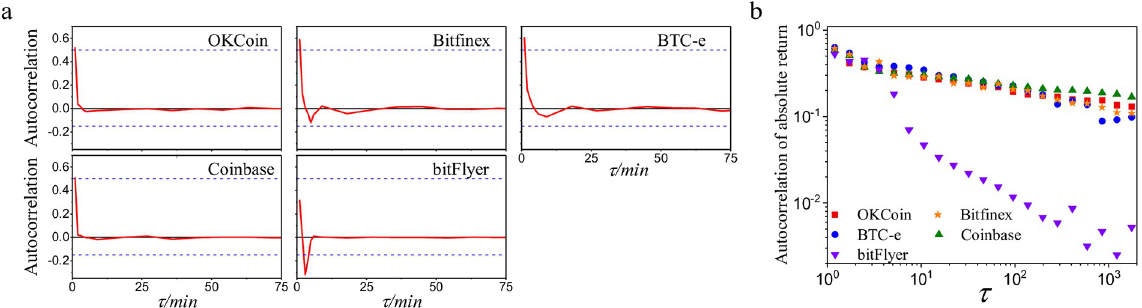
Fig 3. The dependence property of price return. a , The linear autocorrelation of normalized price return in different Bitcoin platforms when time interval Δ t = 2 min. b , The autocorrelation of normalized absolute price return in different Bitcoin platforms when time interval Δ t = 2